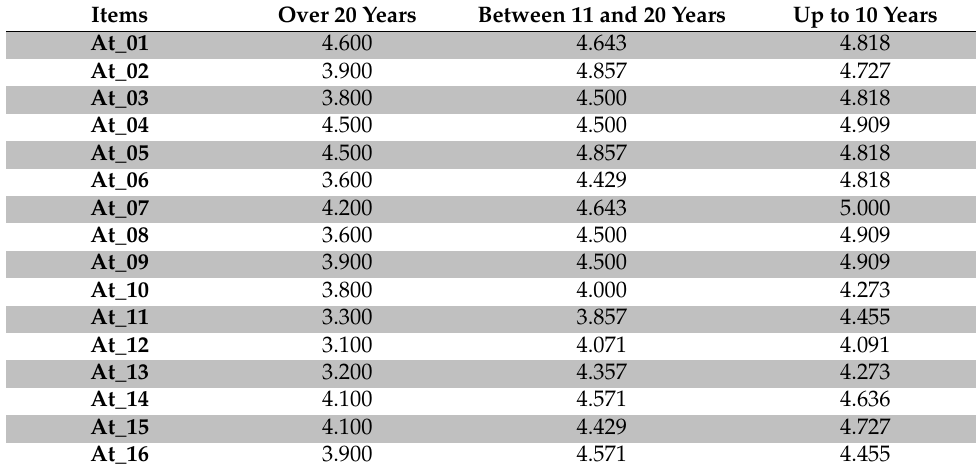
Table 5. Average of the grades of each group for each item.